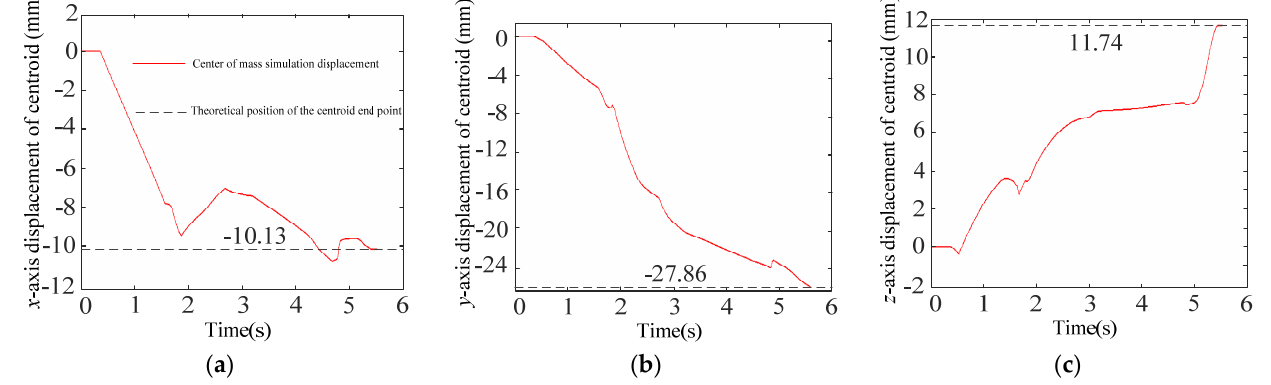
Figure 24. Variation curve for the position of the payload center of mass. ( a ) Variation curve for the position along the x -axis of the payload center of mass; ( b ) Variation curve for the position along the y -axis of the payload center of mass; ( c ) Variation curve for the position along the z -axis of the payload center of mass.